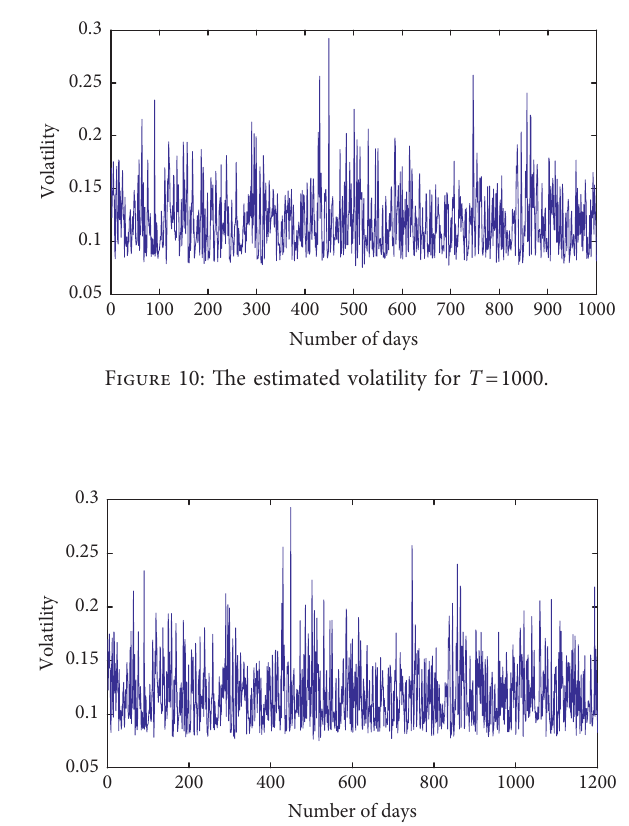
Figure 11: The validation of volatility for T �